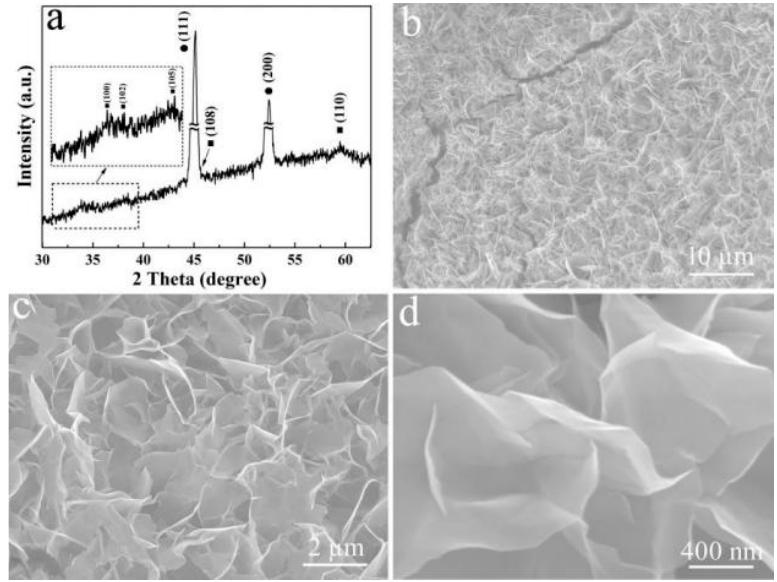
S 2 − [12]. In addition, a broad peak appears at 168.10 eV, which is ascribed to the S-O bond, and the oxygen comes from the hydroxyl groups produced by the hydrolysis of thiourea, as previously reported [24,25].